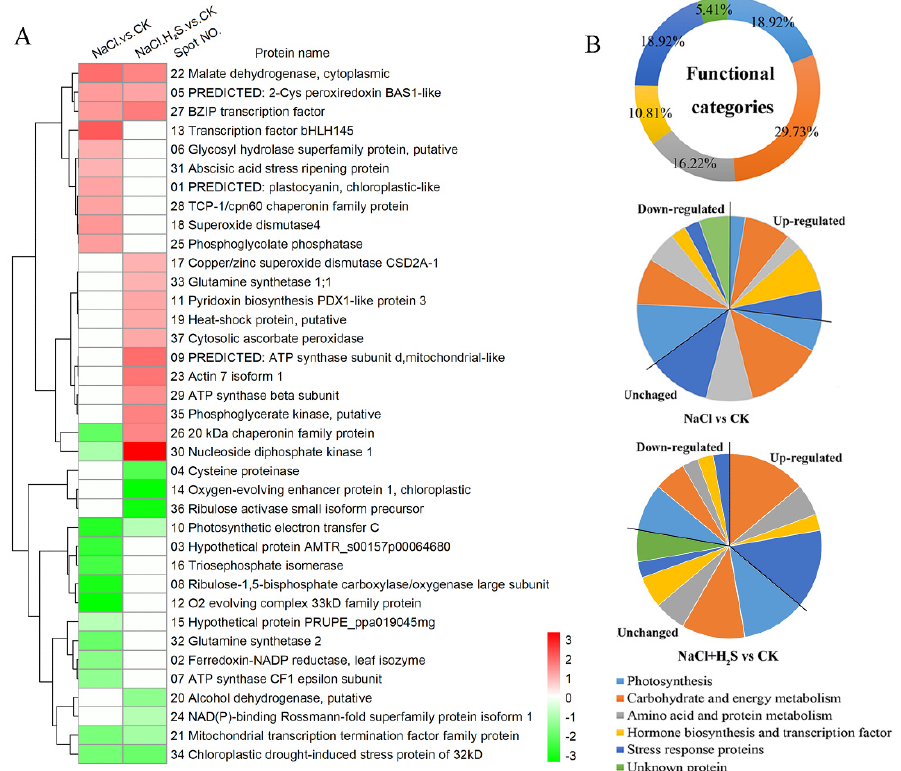
Figure 4. ( A ) Functional classification and hierarchical clustering analysis. ( B ) Functional categories for the 37 differentially expressed proteins in K. obovata seedling leaves under the NaCl treatment and the NaCl and H 2 S treatment. The rows represent the individual proteins. The protein cluster is on the left side, and the treatment cluster is on the top. The up- or down-regulated proteins are indicated in red or green, and white represents no change. The intensity of the color increases with increasing expression differences, as shown in the bar at the bottom of the figure.